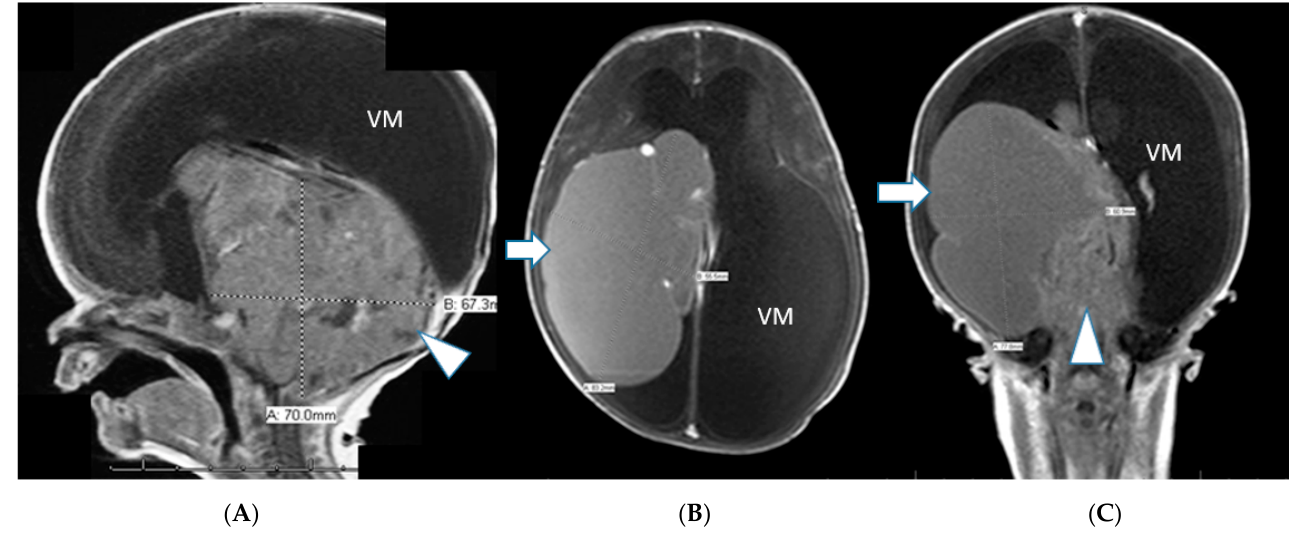
Figure 4. ( A – C ): Postnatal sagittal, axial and coronal T1-weighted contrast enhanced MRI showing an interval progression in tumor size in comparison to prenatal images, measuring 7 cm in diameter with near complete compression and infiltration of the cerebellum and brainstem (arrowhead). Large supratentorial, intraventricular protein rich tumor cyst similar to the prenatal imaging (arrow). Ventriculomegaly (VM).